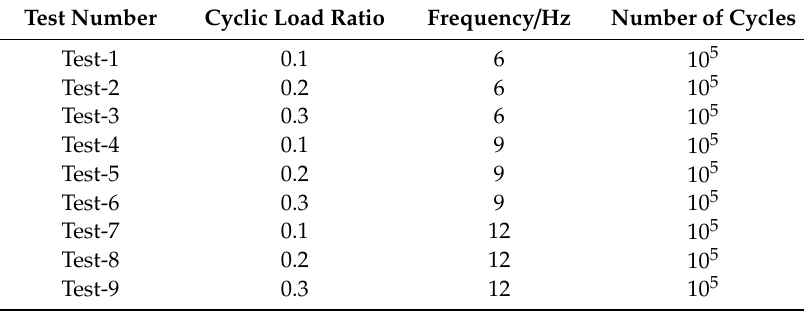
Table 4. Scheme of model test.